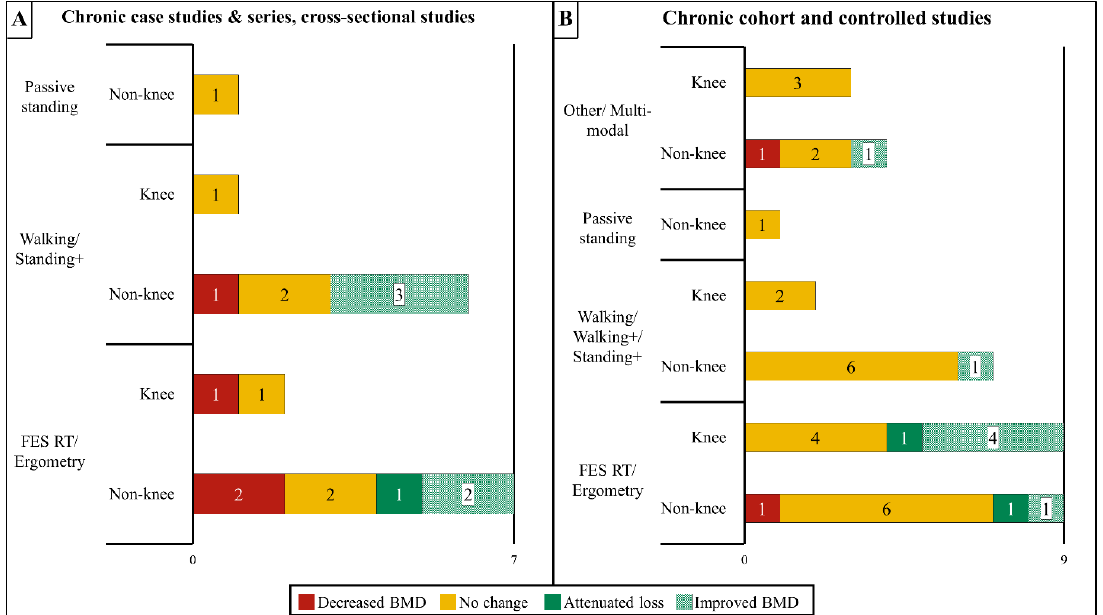
Figure 2. Summary of the effects of activity-based physical therapy (ABPT) on the changes in bone mineral density (BMD) at the knee (distal femur and proximal tibia) or all other sublesional non-knee sites for persons with chronic SCI in ( A ) case studies, case series, and cross-sectional studies, or ( B ) controlled and cohort studies. The data are reported as described in Figure 1A,B. Overall, most studies on persons with chronic SCI reported that ABPT did not alter BMD with only four studies reporting improved BMD at the knee. FES, functional electric stimulation; RT, resistance training; “Walking+” refers to interventions that combined walking ABPT with FES or nerve stimulation; “Standing+” refers to interventions that combined standing modalities with other modalities that increase muscle activation such as FES or vibration.